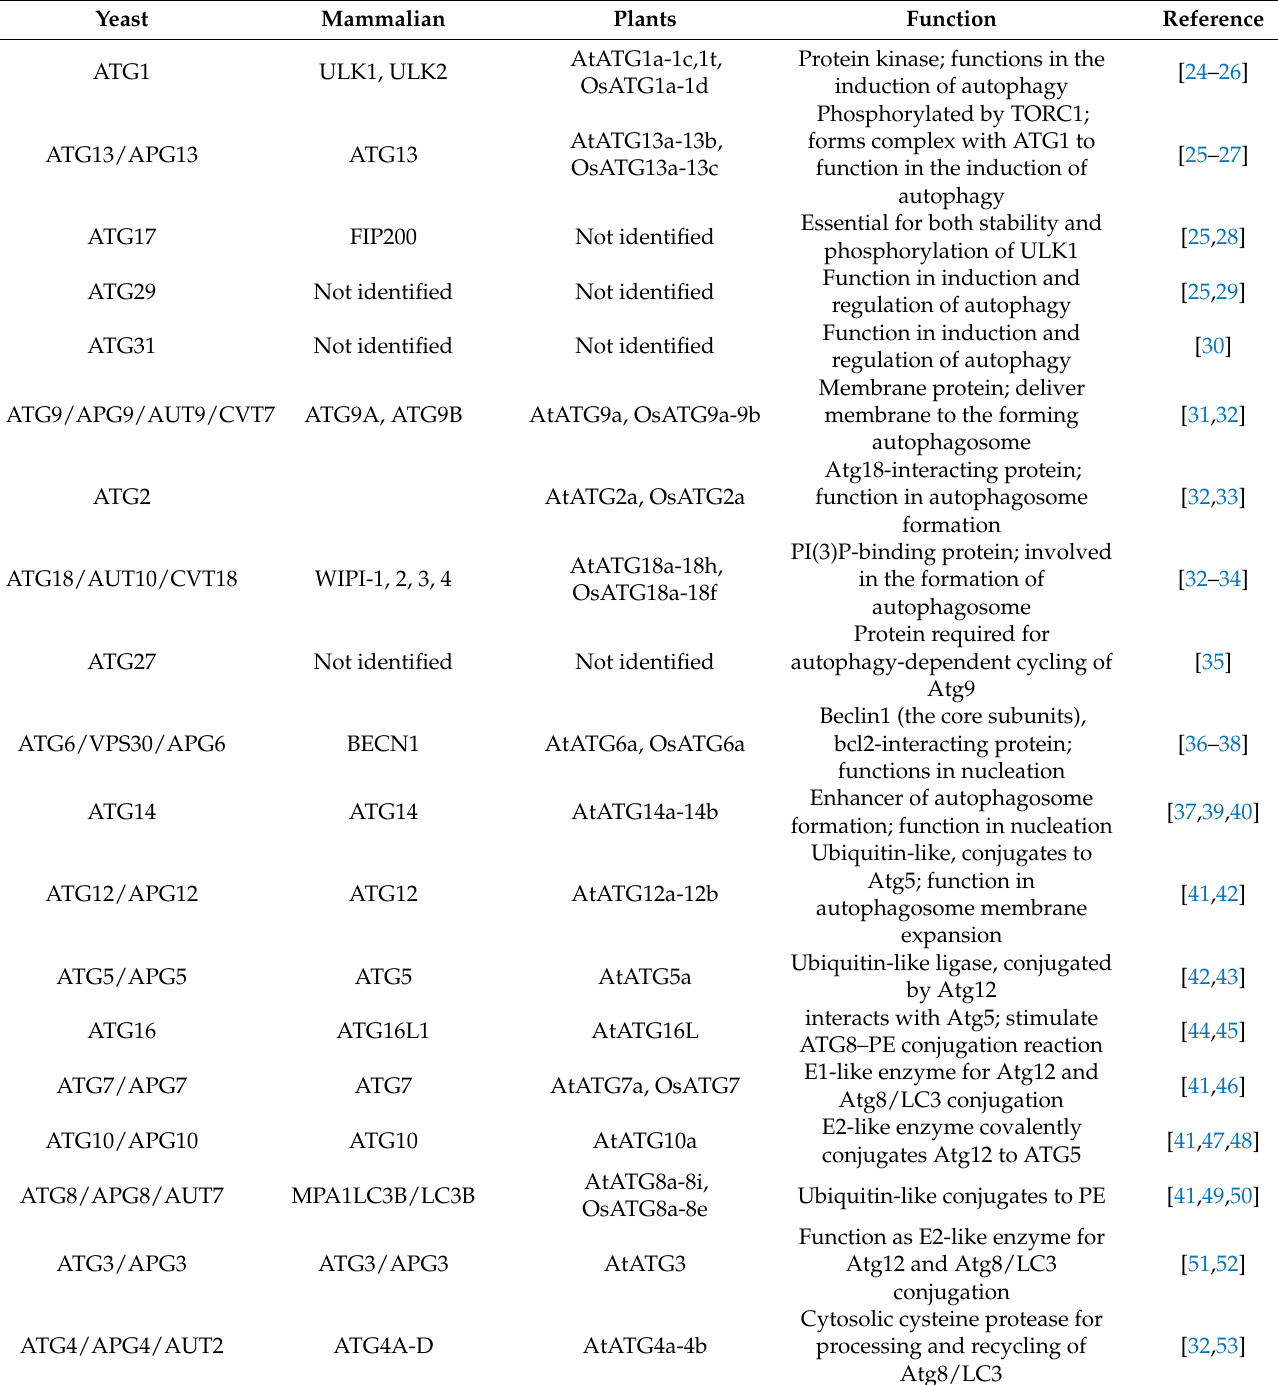
Table 1. Identified ATGs genes in yeast, mammals, and